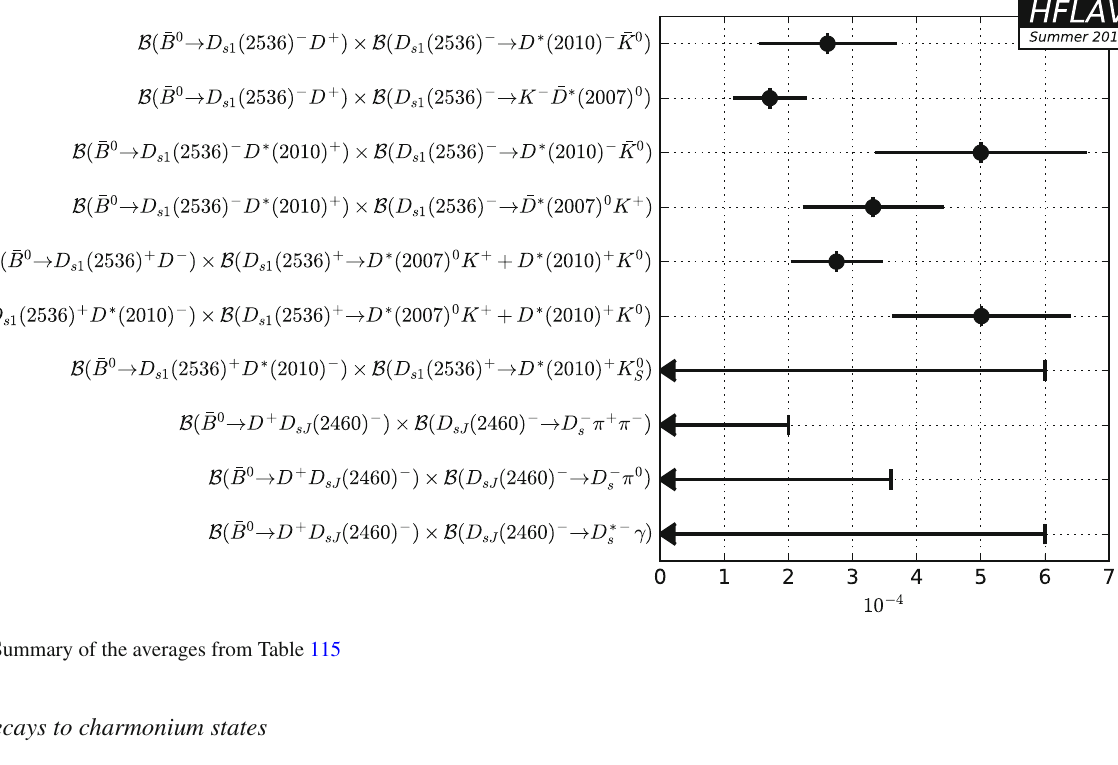
¯ B 0 decays to charmonium states are shown in Tables 116, 117, 118, 119, 120, 121, 122, 123, 124 and Figs. 90, Averages of 91, 92, 93, 94, 95, 96, 97, 98.